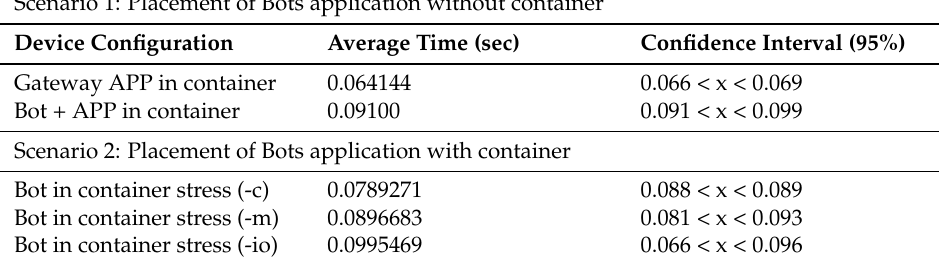
Table 4. Communication delay with bots in container with respect to stress parameters.